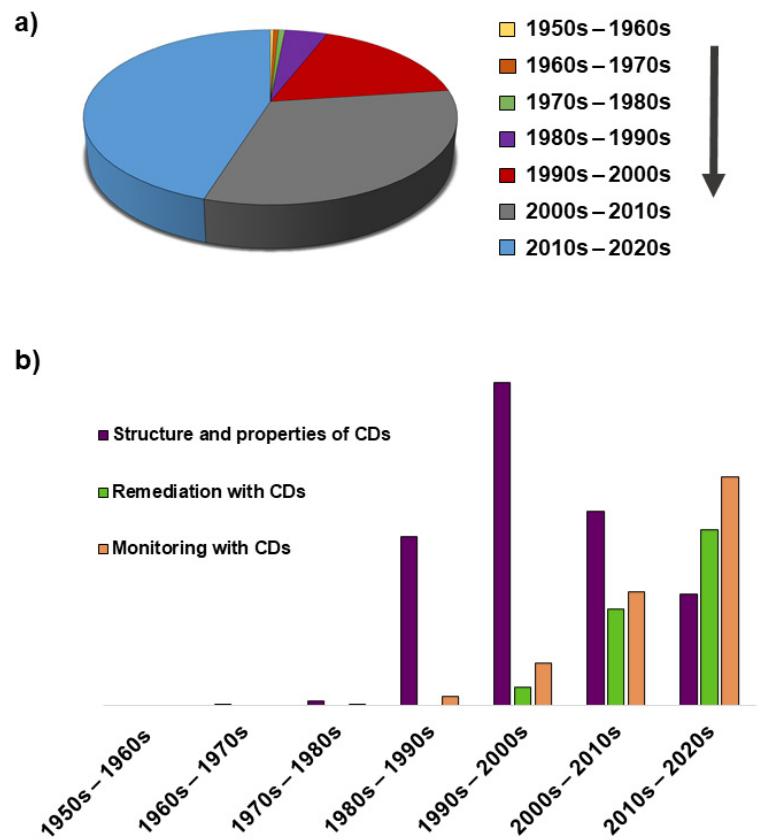
Figure 6. Graphic summary of the progression in the number of works on CDs reported over the years in the literature: ( a ) number of publications talking about CDs, whatever the focus is, and ( b ) evolution in the number of publications on the basic structure and properties of CDs, and their use for remediation and monitoring purposes.